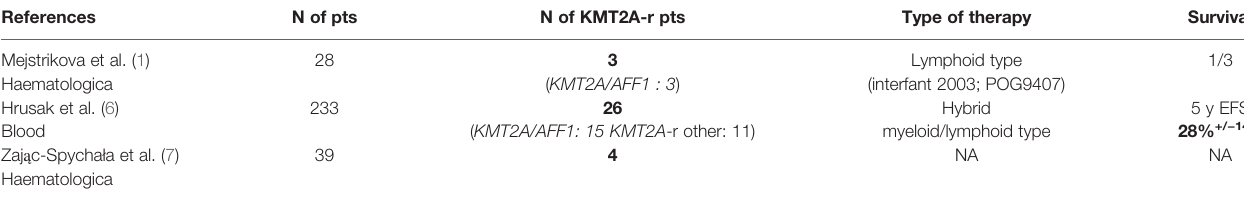
TABLE 1 | KMT2A -rerranged MPAL cases from literature and their treatment